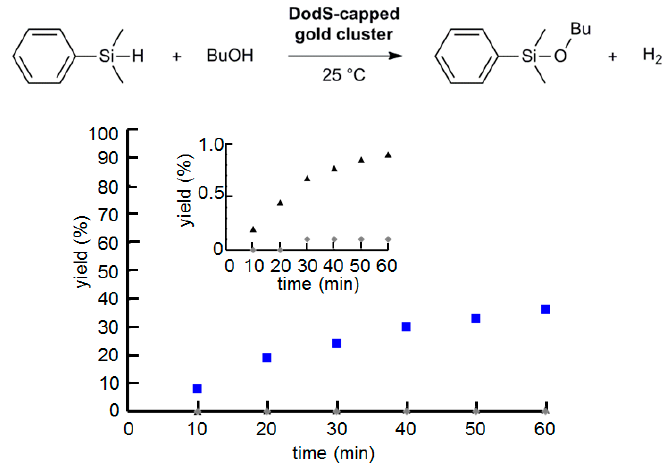
Figure 7. Time-course reaction profile of thiolated gold nanoclusters towards silane alcoholysis. Black triangle: Octyl 4 N[Au 25 (SDod) 18 ], gray diamond: Na[Au 25 (SG) 18 ], and blue square: Au 38 (SDod) 24 . Reaction condition: DMPS (150 umol), BuOH (3.0 mL), and gold nanoclusters (0.08 mol %) at 25 °C. The inset is a magnified portion at lower reaction yields.